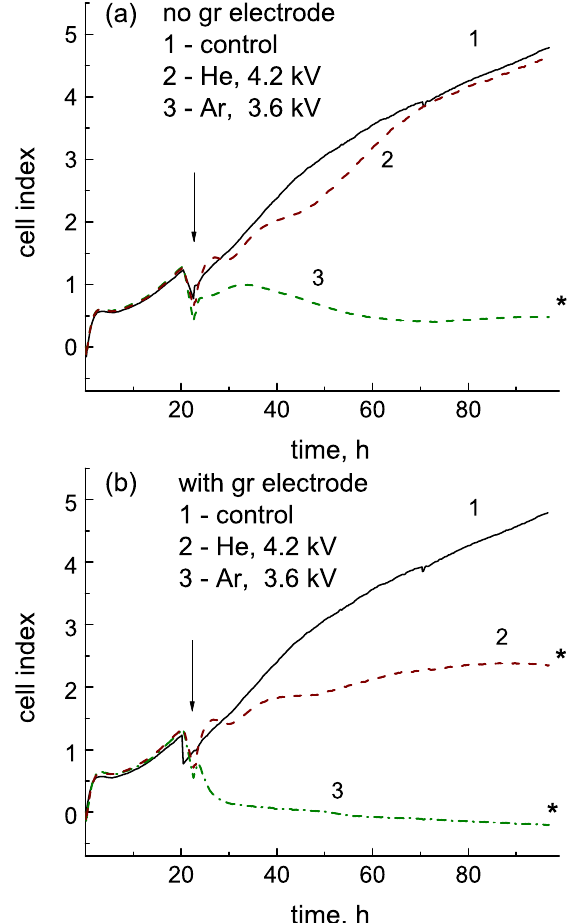
Figure 14. iCELLigence data showing typical Cell Index curves (CI) that reflect cell proliferation in real-time mode. Data are presented as average of three independent repeats. A549 cells were irradiated without the grounded substrate ( a ) or with it ( b ) for U = 4.2 kV and v = 5 L/min (helium) or 3.6 kV and v = 3 L/min (argon). The point at which cells were irradiated by CAP is indicated by the arrow. Students t-test was used to compare treatment effects, and the difference between control and groups was statistically significant at * p <